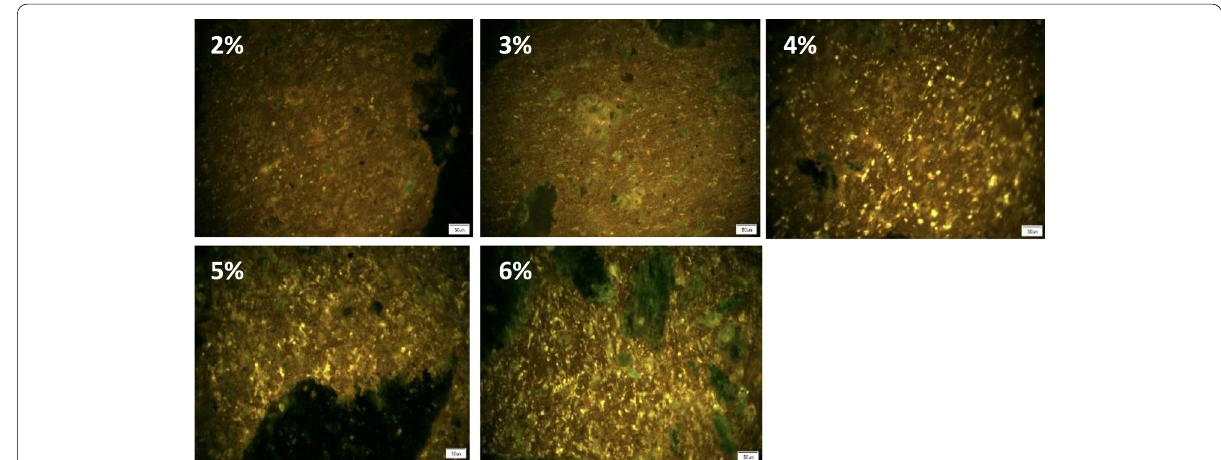
Fig. 5 Fluorescence images of SBS modifier in mixtures at a different adding ratio (image size: 1.4 mm